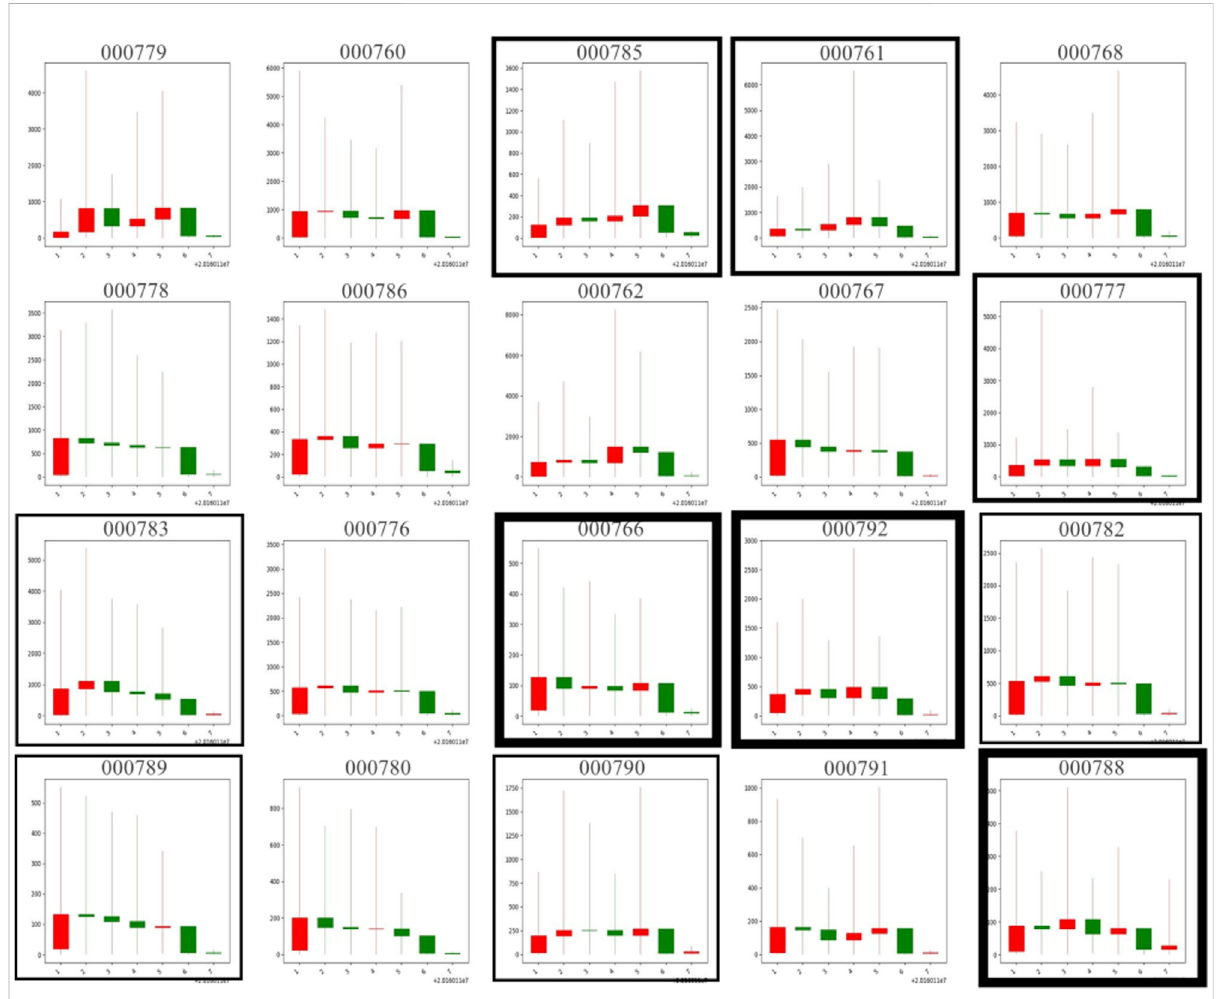
FIGURE 4 Partial clustering results of image-based clustering results on the sample week. Borders of the same thickness are grouped in the same cluster, in which 000761 (BENGANGBANCAI Stock), 000777 (ZHONGHEKEJI Stock), and 000785 (WUHANZHONGSHANG Stock) are in one cluster. The horizontal axis represents the date and the vertical axis represents the search volume on the day in each